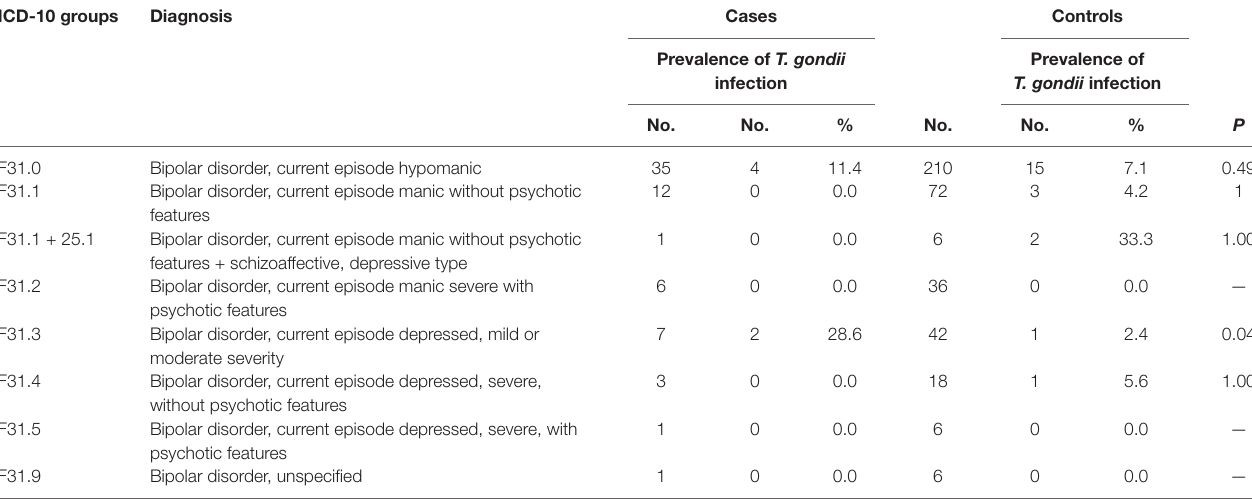
TABle 2 | Comparison of Toxoplasma gondii seropositivity rates in cases and controls according to International Classification of Diseases, 10th Revision ( ICD-10 ) diagnosis groups. ICD-10